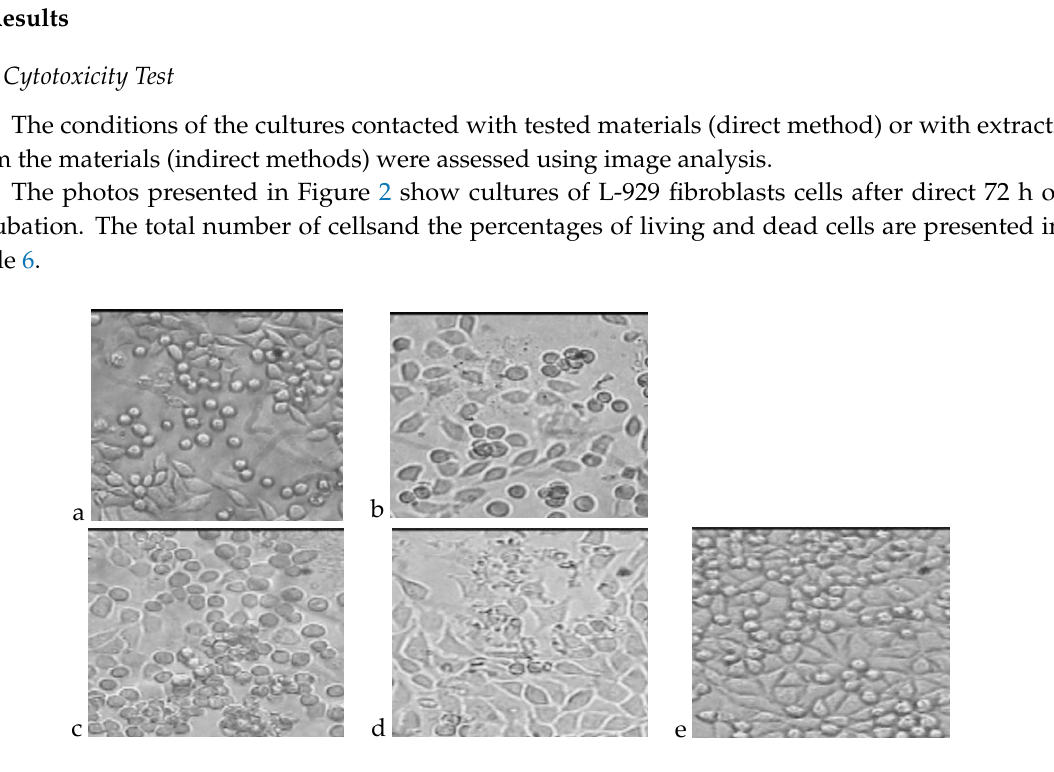
Figure 2. L929 cell cultures obtained during the cytotoxicity test of the direct method after 72 h of incubation. ( a ) Cells incubated with PLGA; ( b ) Cells incubated with PLGA + IGF1; ( c ) Cells incubated with PLGA/PHB; ( d ) Cells incubated with PLGA/PHB + IGF1; ( e ) L-929 culture without contact with tested materials. Table 6. Number of cells and level of cytotoxicity after 72 h of incubation—direct method.